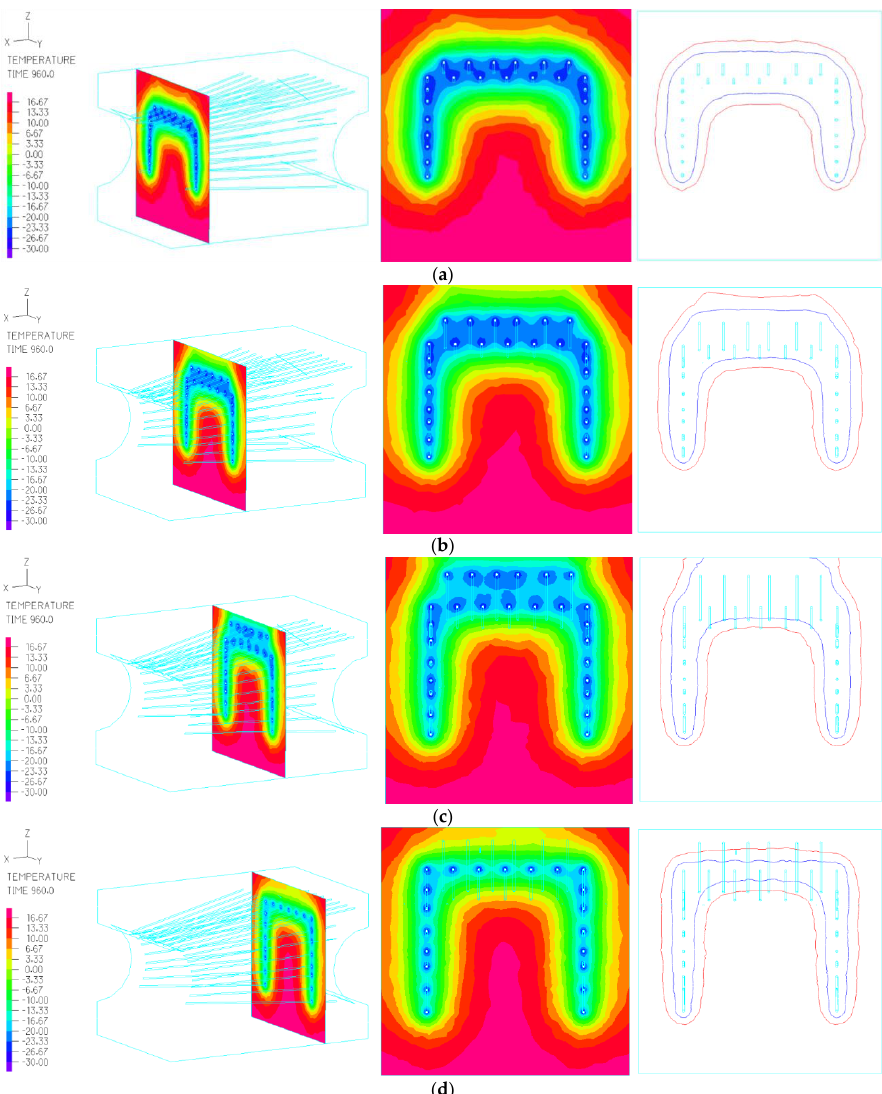
Figure 6. Freezing curtain under 40-day freezing. ( a ) x = −3.0 m, ( b ) x = −6.0 m, ( c ) x = −9.0 m, ( d ) x = −12.0 m.